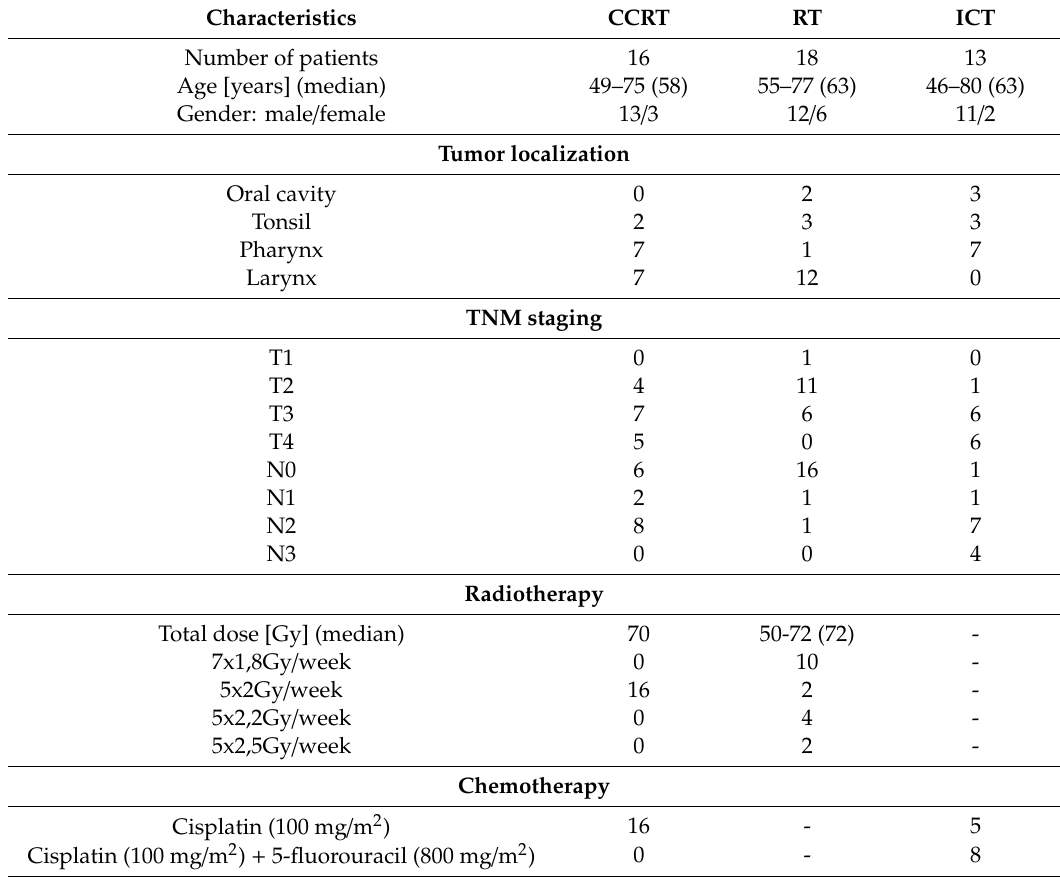
Table 3. Summary of clinical characteristics of the